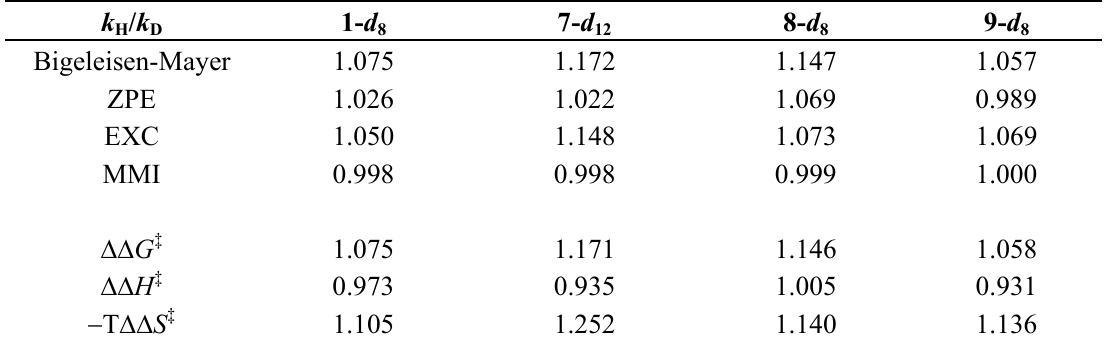
Table 3. Computed CKIEs for compounds 1 and 7 – 9 using scaled B3LYP/6-31G(d,p) harmonic frequencies (368 K) via the Bigeleisen-Mayer or  H  S